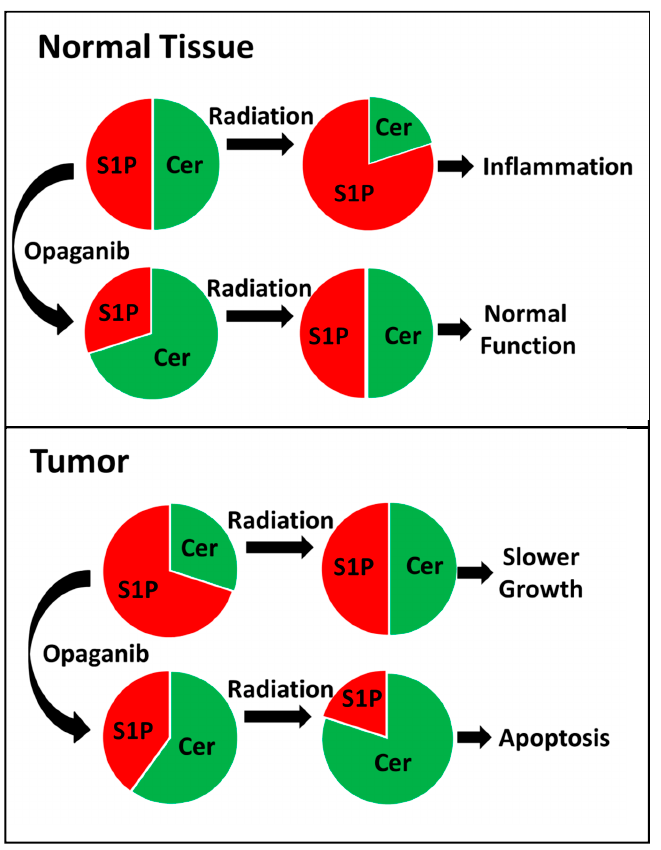
Figure 11. Model for prevention of GI-ARS and concurrent sensitization of tumor cells to killing by radiation. Levels of S1P and ceramides are represented by red and green slices, respectively. In normal GI tissue, radiation causes an increase in S1P leading to inflammatory tissue damage. Because opaganib treatment reduces the basal level of S1P in the GI tissue, the increase following radiation is insufficient to generate the pathologic inflammatory tissue response. In tumor tissue, the basal level of S1P is higher than normal tissue due to growth factor and/or oncogene driven sphingolipid hydrolysis, and in this case radiation elevates ceramide levels thereby decreasing tumor growth. Treatment of tumors with opaganib restores the resting S1P/ceramide balance and prevents radiation-stimulation of S1P formation, leading to elevation of ceramide sufficient to drive tumor cells into apoptosis.